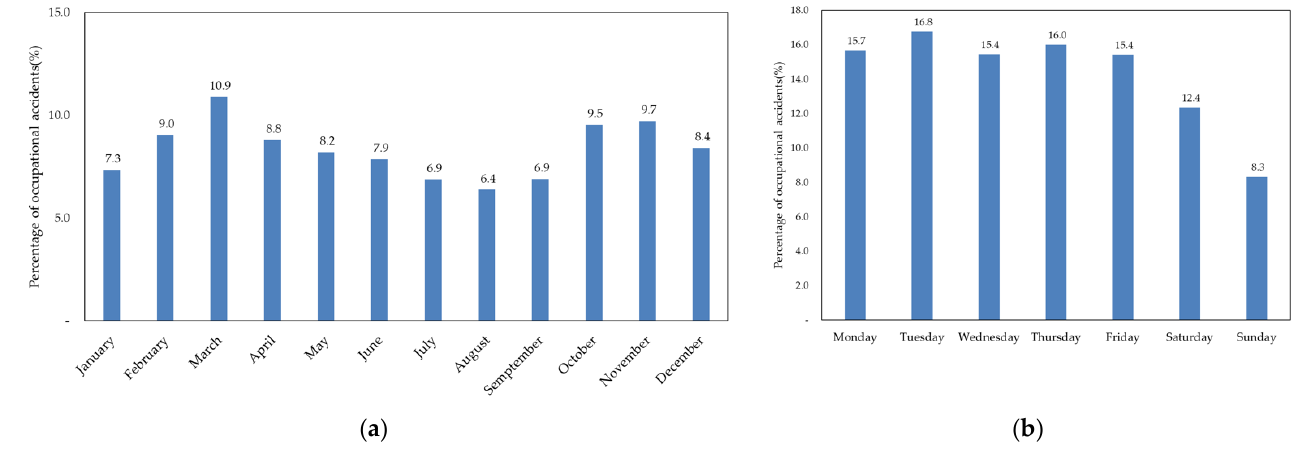
Figure 3. Distribution of occupational accident rates annually between 2010 and 2020: ( a ) month and ( b ) day of week.